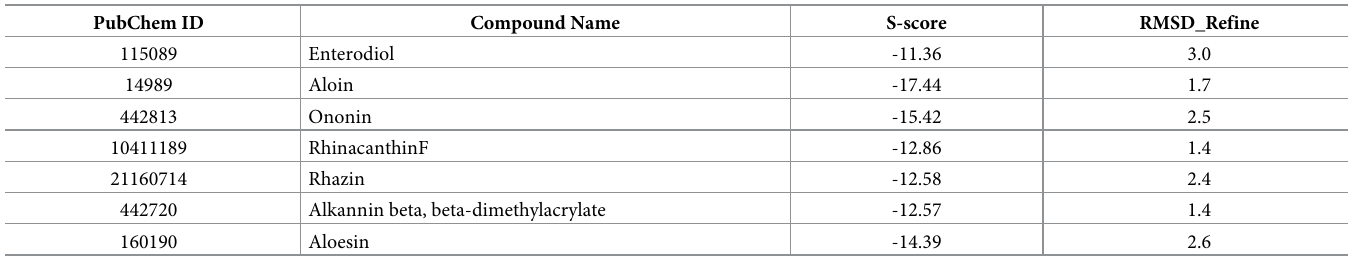
Table 4. The table displays the docking score and RMSD value for the compounds.